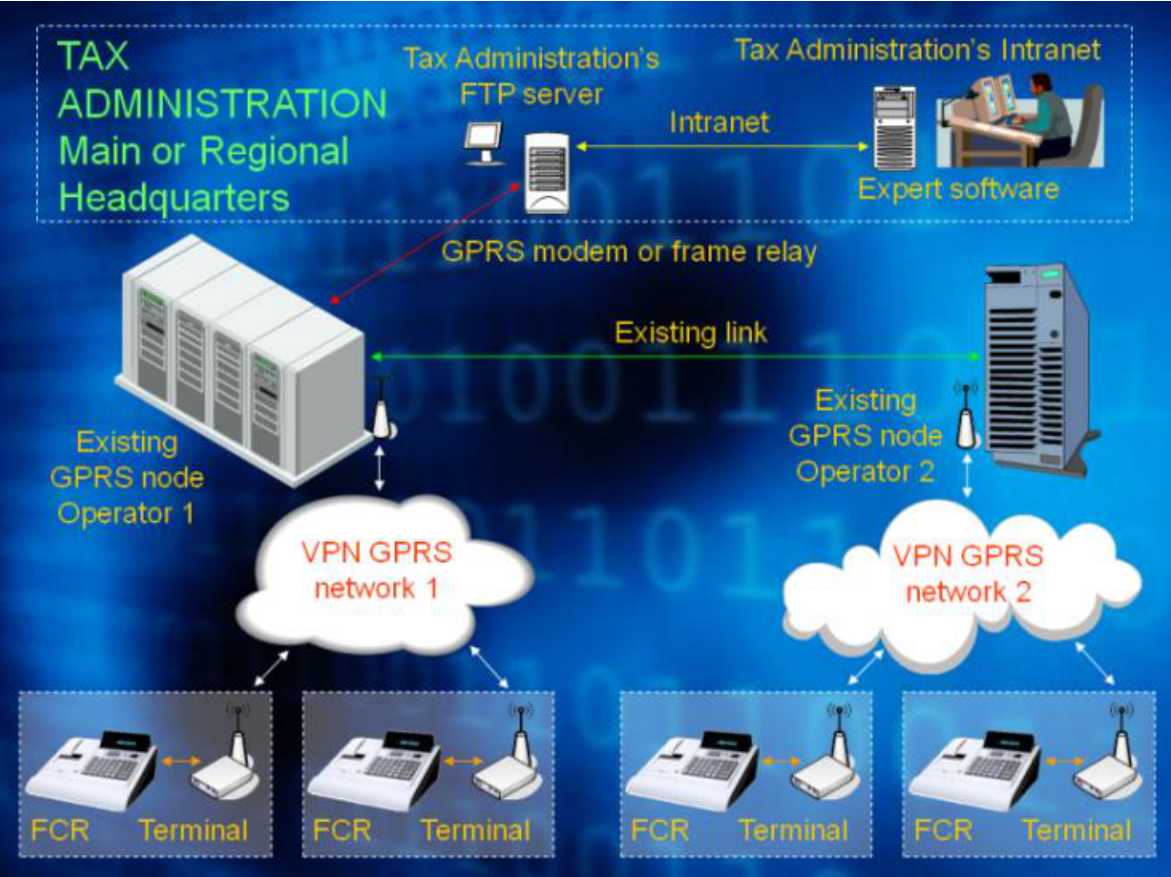
Figure 5. The subsystem for remote control of fiscal cash registers.